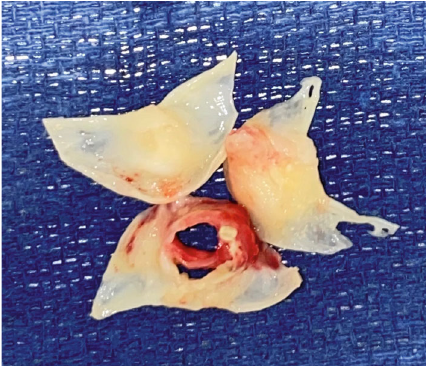
Figure 3: Resected aortic valve with vegetation on the left coronary cusp and perforation of the right coronary cusp.